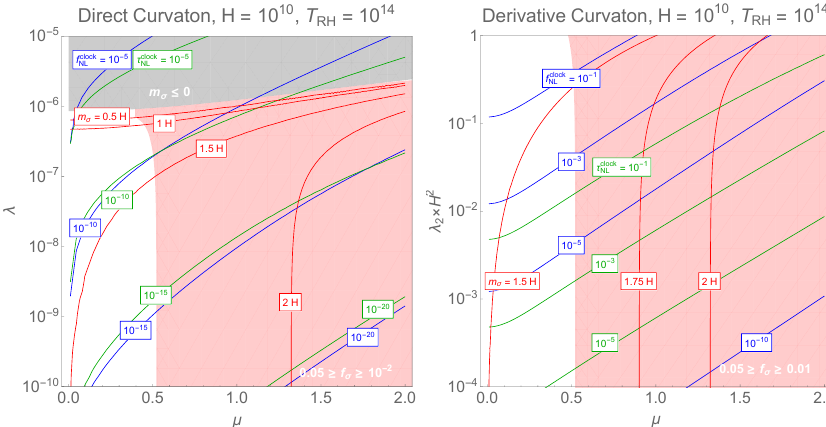
Figure 3 . Numerical benchmarks of the curvaton scenario, H and T RH in the unit of GeV. The gray region corresponds to when the bare m (cid:27) becomes negative, and the red contours stand for m (cid:27) in the unit of H . The blue (green) contour stands for bispectrum (trispectrum) clock signals. The red region provides enough DM this way (0 : 05 > f (cid:27) > 0 : 01 with a proper choice of parameter A between 10 3 and 10 7 ). Left: direct coupling. Right: derivative